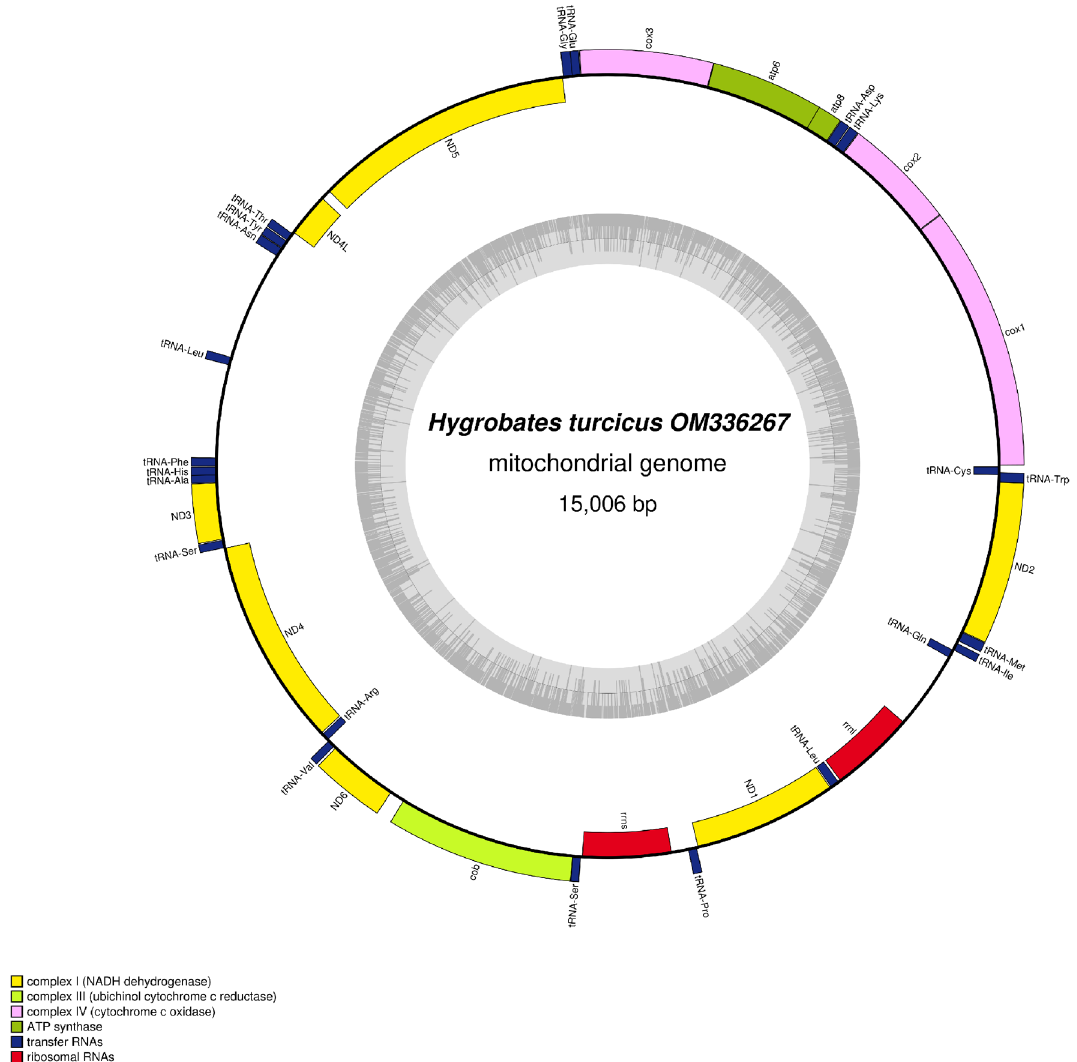
Figure 1. Map of the mitochondrial genome of Hygrobates turcicus . Genes belonging to different functional groups are color coded differently and the GC, AT content of the genome are plotted on the inner circle as dark and light gray,